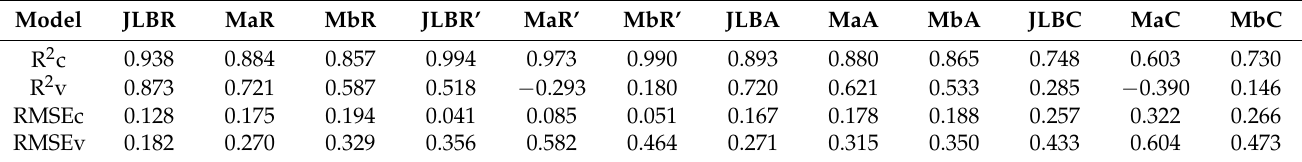
Table 5. Estimation accuracy of PLS models in the soil moisture control experiment.